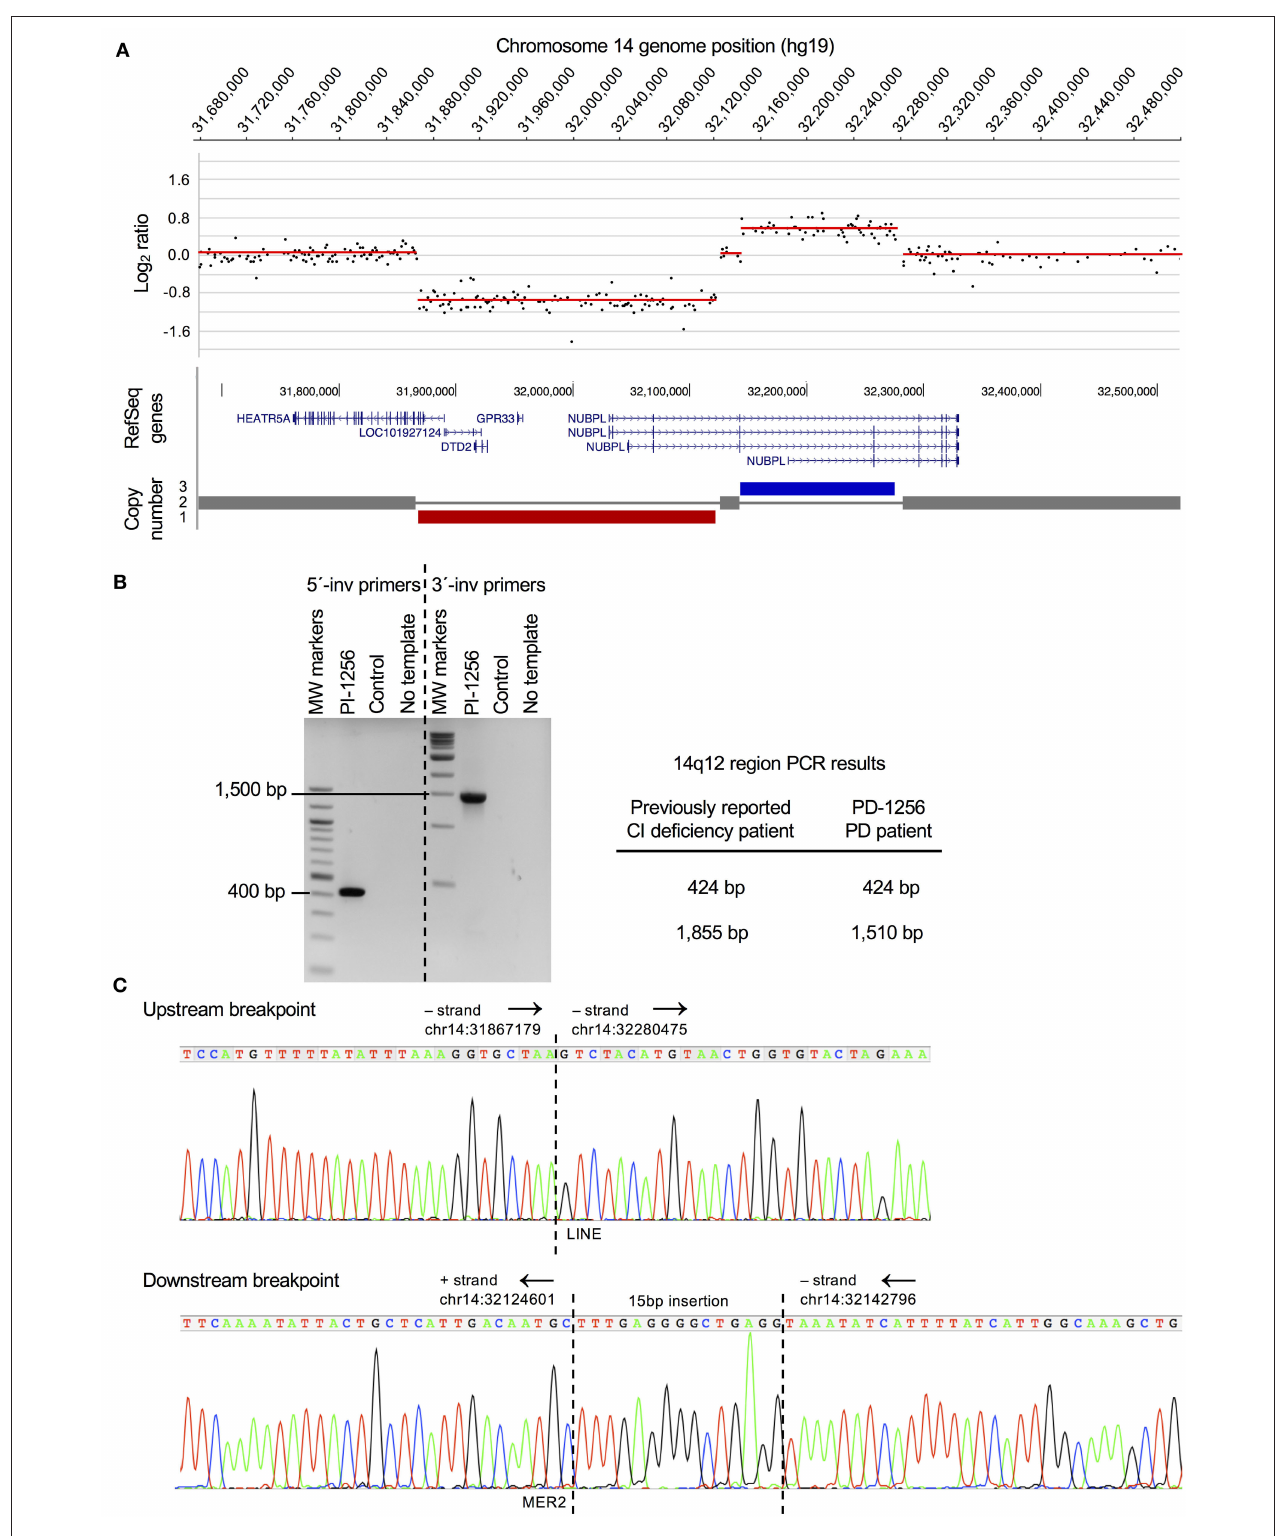
FIGURE 1 | PD case with a chromosomal rearrangement disrupting CI assembly factor gene NUBPL . (A) Genome-wide CNV (aCGH) analysis revealed a complex chromosomal rearrangement in a female patient diagnosed with sporadic PD that consists of a 254Kb deletion (hg19, chr14:31867829-32121888) and